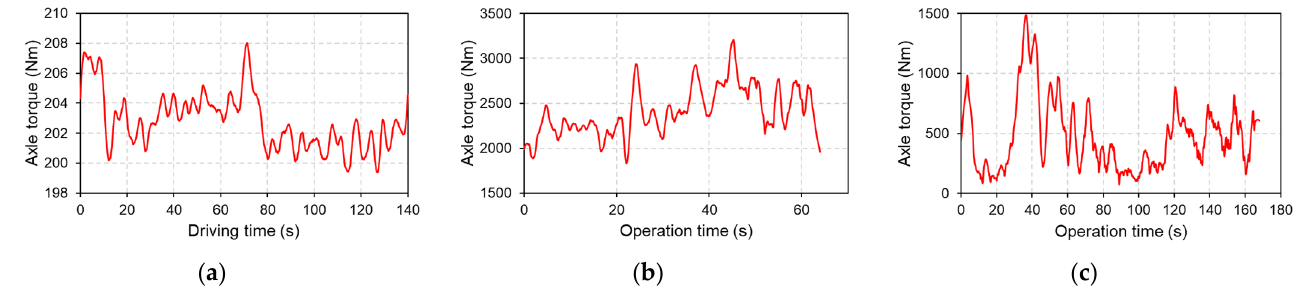
Figure 6. Axle loads of the target partial PST tractor during operations. ( a ) Asphalt driving, ( b ) plow tillage, ( c ) rotary tillage.